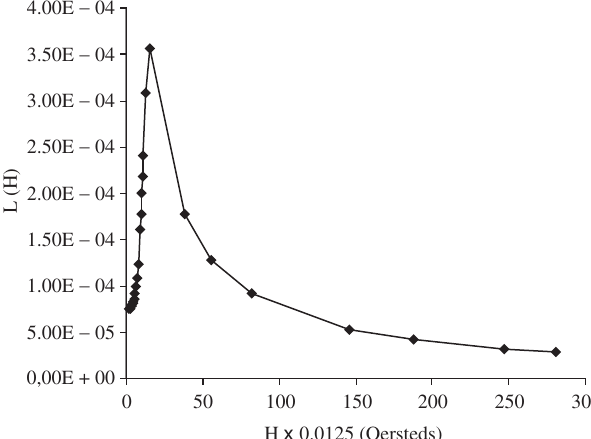
Figure 6. Variation of inductance in relation to the applied field of as-cast alloys, at a frequency of